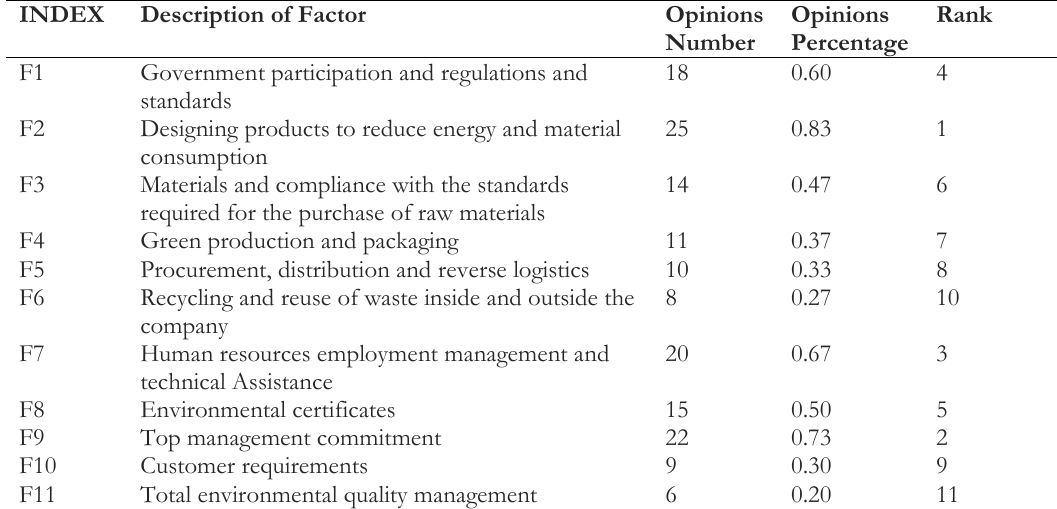
Table 7. Opinions percentage and rank of each index.